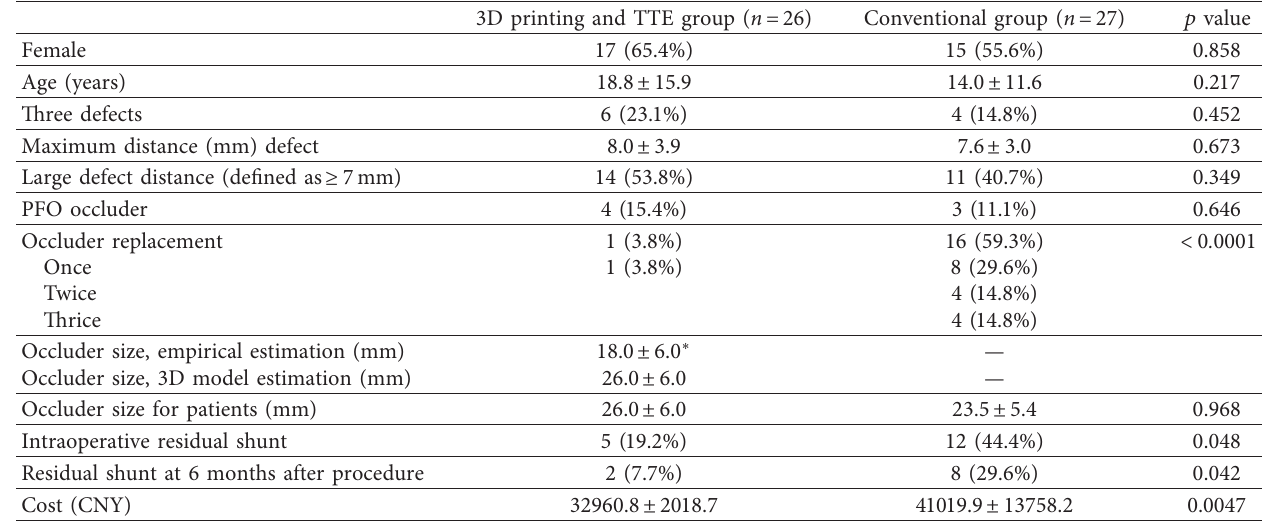
Table 1: Patients’ data.